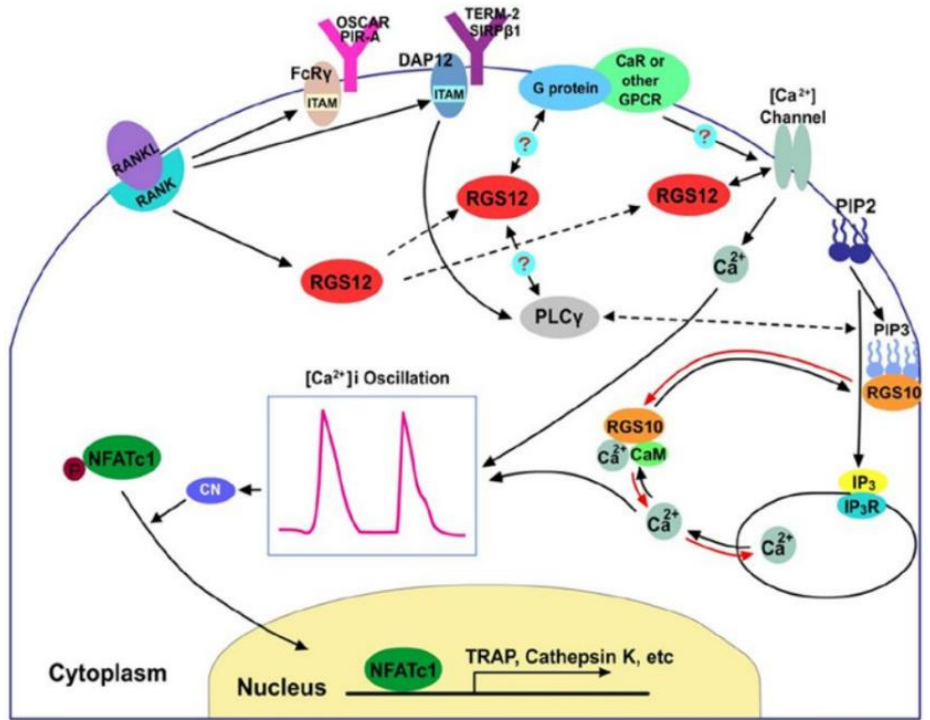
Figure 2. A proposed working model of RGS proteins in the regulation of the calcium oscillation-NFATc1 signal pathway for osteoclast differentiation. Reprinted/adapted with permission from Ref. [16]. 2014, Intini, G.